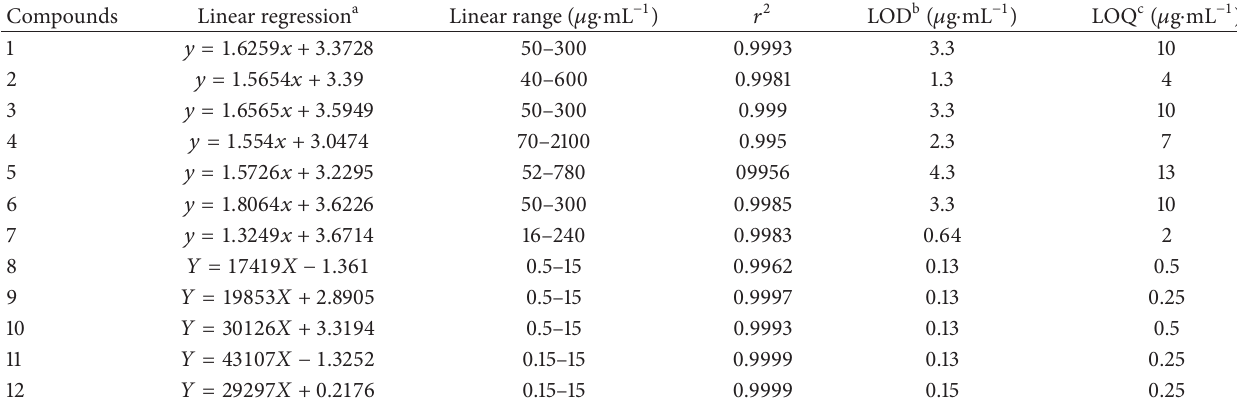
Table 1: Linear regression data, LODs, and LOQs for the twelve compounds.